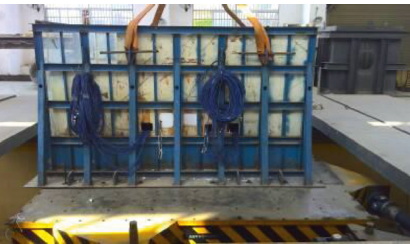
Figure 4: Shaking table test.